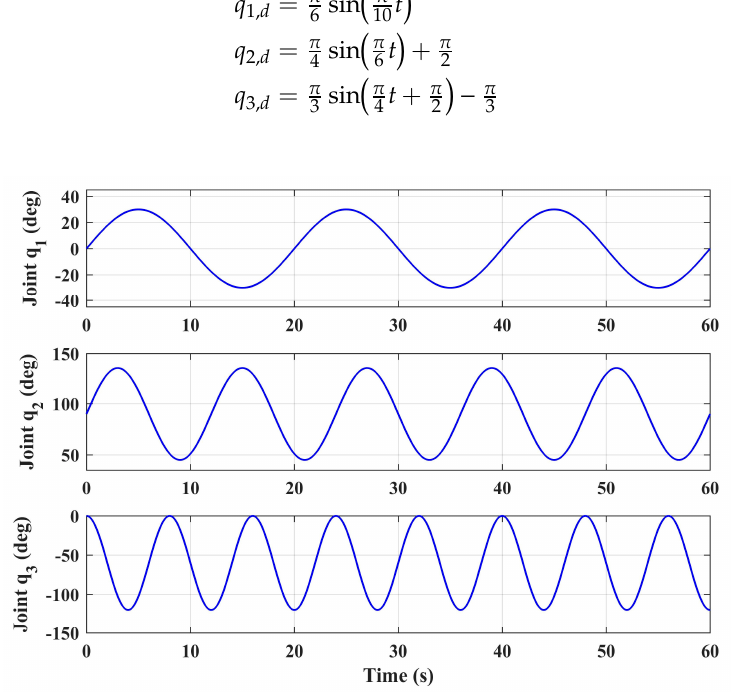
Figure 6. Joint angles in flight test simulation.